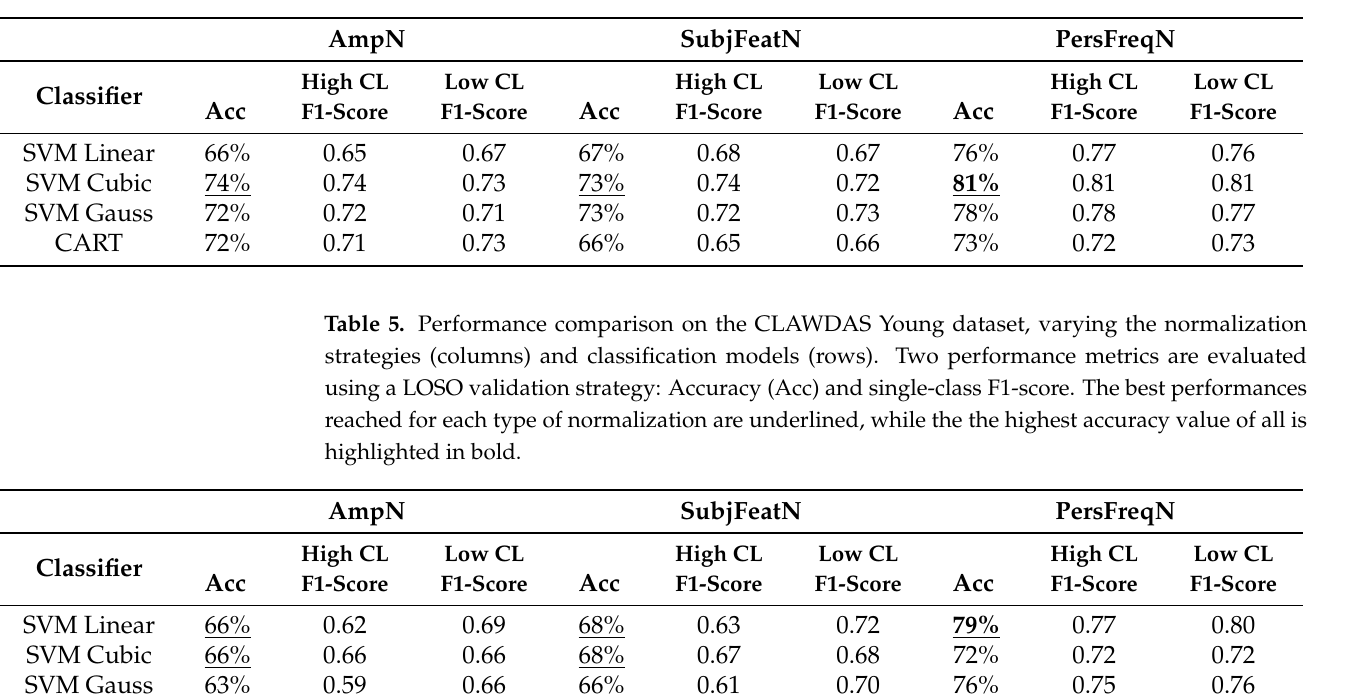
Table 4. Performance comparison on the CLAS dataset, varying the normalization strategies (columns) and classification models (rows). Two performance metrics are evaluated using a LOSO validation strategy: Accuracy (Acc) and single-class F1-score. The best performances reached for each type of normalization are underlined, while the highest accuracy value of all is highlighted in bold.